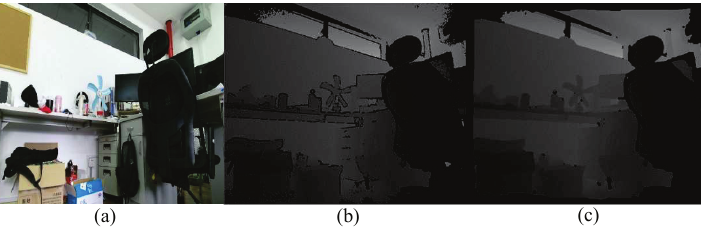
Figure 12. Kinect depth image alignment: ( a ) original scene image, ( b ) kinect acquisition depth map, ( c ) image alignment result.